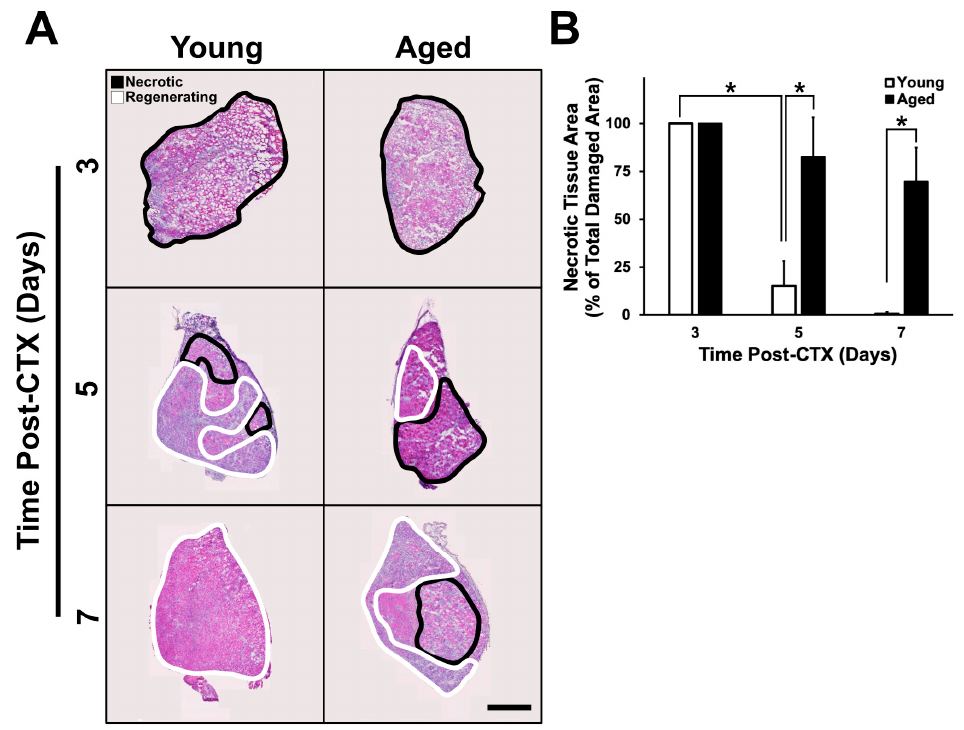
Figure 3. Necrosis is increased in aged muscle regeneration. ( A ) Representative images of whole muscle sections undergoing regeneration at their respective time points. ( B ) A significant interaction between age and recovery time points was identified ( p < 0.001). Necrotic regions were found to be identical three days following damage in young and aged muscle, however, necrotic area decreased significantly in young muscle at five days following damage (simple main effects post-hoc analysis: p < 0.001 in all instances). The * indicates significant differences detected by a simple main effects post-hoc analysis ( p < 0.001). n = 4–5 per group. Data presented are means ± standard deviation. Scale bar represents 500 μ m.